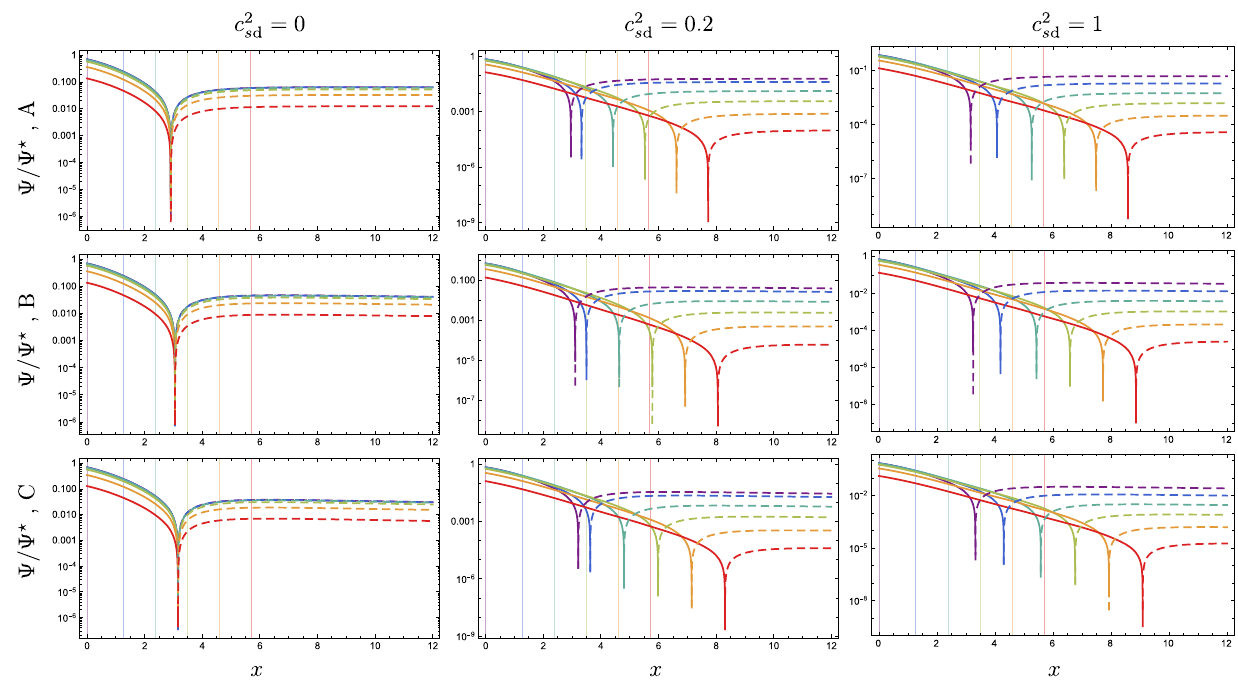
same criteria as the ones used in Fig. 3 to represent the different modes. The coloured vertical lines represent the moment of horizon exit for the corresponding mode